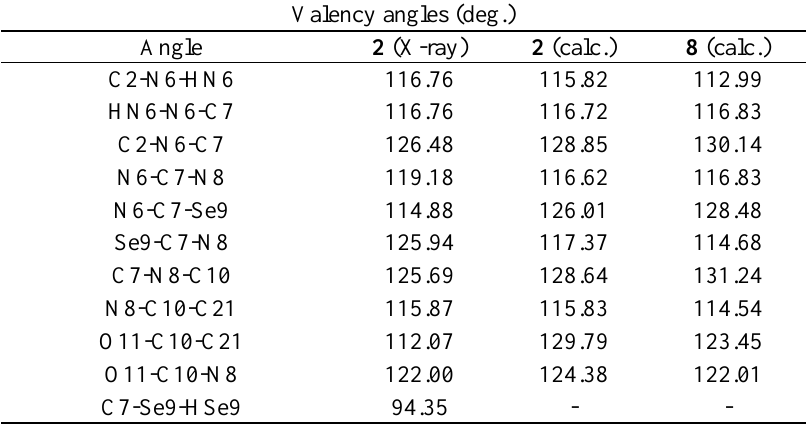
Table 2. Selected valency angles in 2 and 8 .